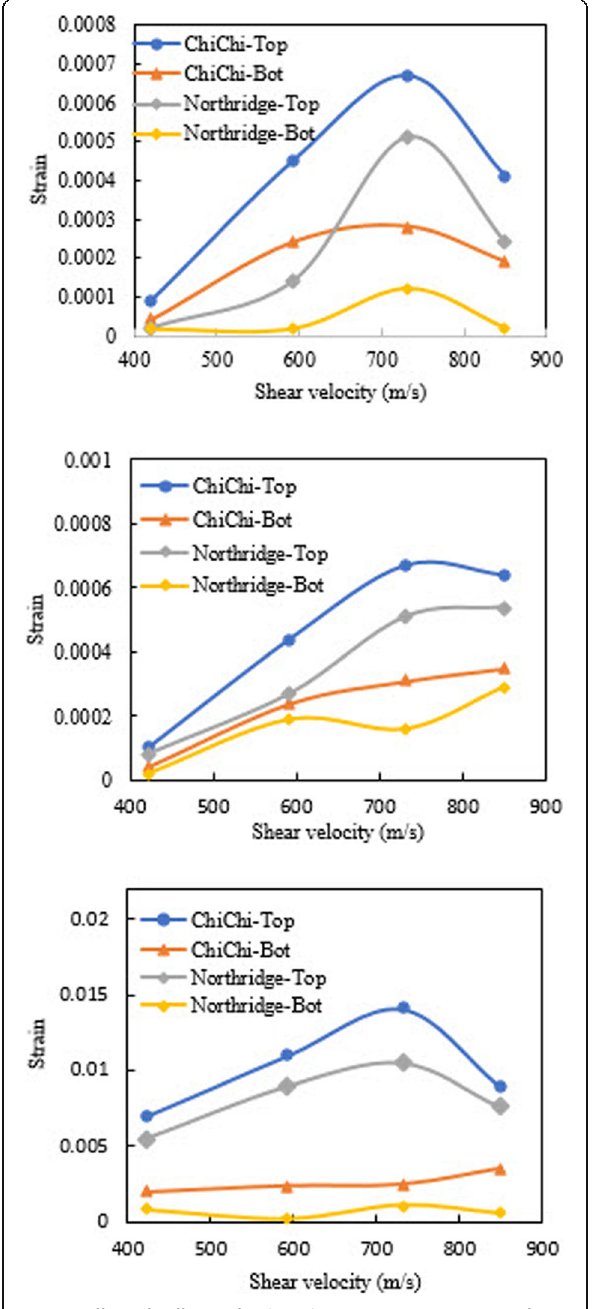
Fig. 17 Effect of stiffness of soil medium on maximum strain of pipeline elbows at crest and toe of slope: ( a ) SF = 0.3; ( b ) SF = 0.5; ( c ) SF = 0.7